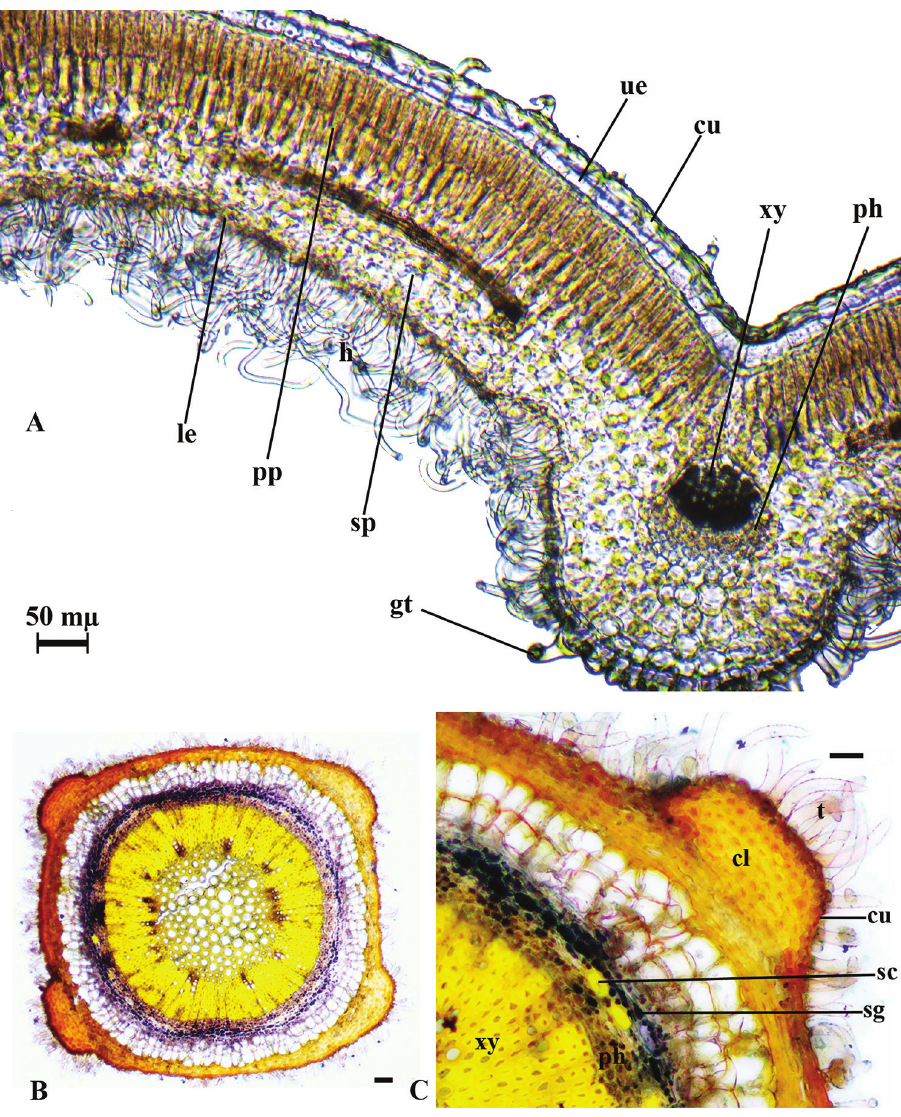
Figure 4. T. brevifolium, cross-section of the leaf ( A ), stem ( B, C ); cl: collenchyma; cu : cuticle; gt: glandu- lar trichomes; le: lower epidermis; ph: phloem; pp: palisade parenchyma; sc: sclerenchyma; scr: sphaerocrys- tal, sg: starch grains; sp: spongy parenchyma; t: trichome; ue: upper epidermis; xy: xylem; Scale bars: 50 mμ. Starch accumulated in both spongy and palisade parenchyma. Midrib has 5–6 layered collenchyma and 1–2 layered parenchyma below the lower epidermis. The col- lateral vascular bundle is located in the central part of the midvein. The xylem layer is found under the collenchyma. 1–2 layered parenchyma and 2–3 layered collenchyma are located under the phloem (Figure